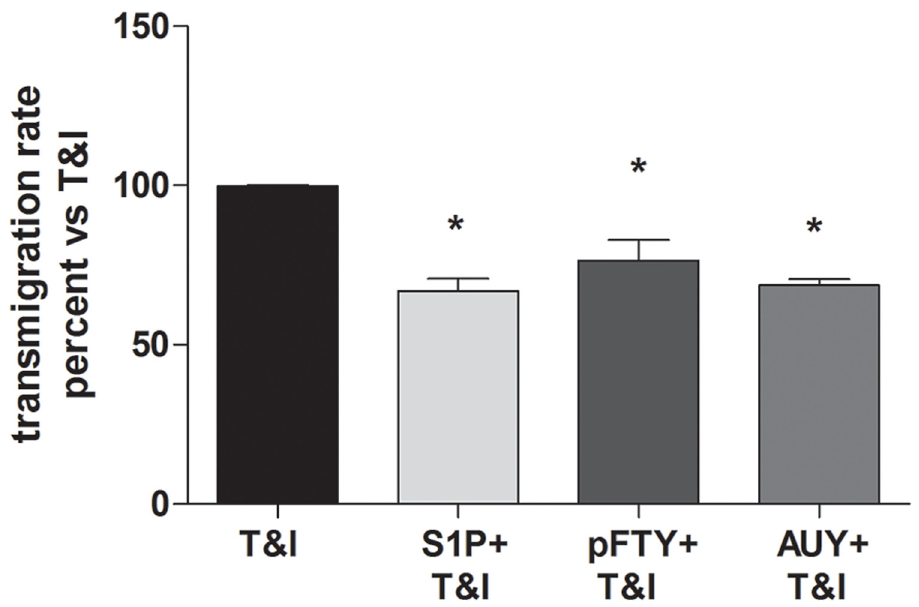
Fig 7. S1P modulation reduces transmigration of PBMCs across an in vitro BBB model under shear stress. When hBMVEC/hAST co-culture was exposed to T&I in the presence of S1P (50 nM), pFTY (50 nM), or AUY (50 nM), the ability of PBMCs to migrate through the barrier is reduced if compared to the condition in which the barrier is exposed only to cytokines. Data are mean of 2 independent experiments and are expressed as percent reduction in PBMC migration after 1 hour compared to T&I. * p < 0.05 vs